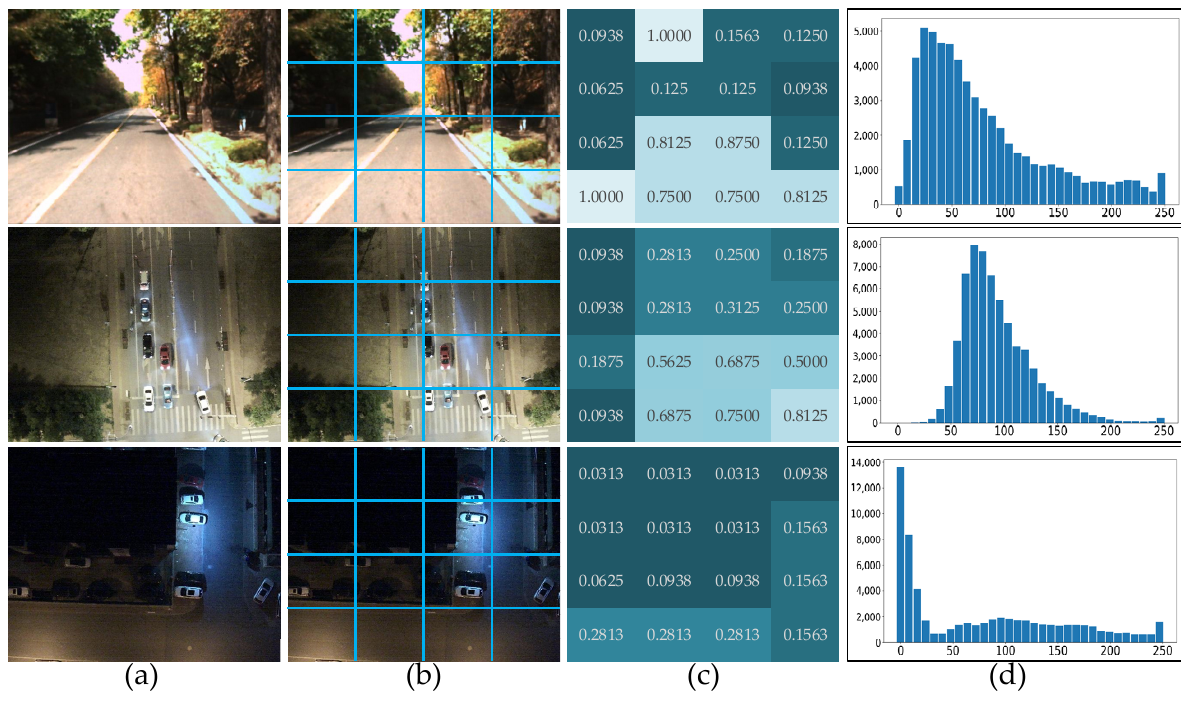
Figure 4. ( a ) Original image . ( b ) The original image is divided into grid cells, and the sample image is divided into 16 grid cells. ( c ) The design value of the illumination condition in each area of the image is shown, where the value 1 represents the strongest and the value 0 represents the weakest. ( d ) The histogram of the pixels in the third block of the second row of the partition, where the RGB values are divided into 32 intervals for statistics.